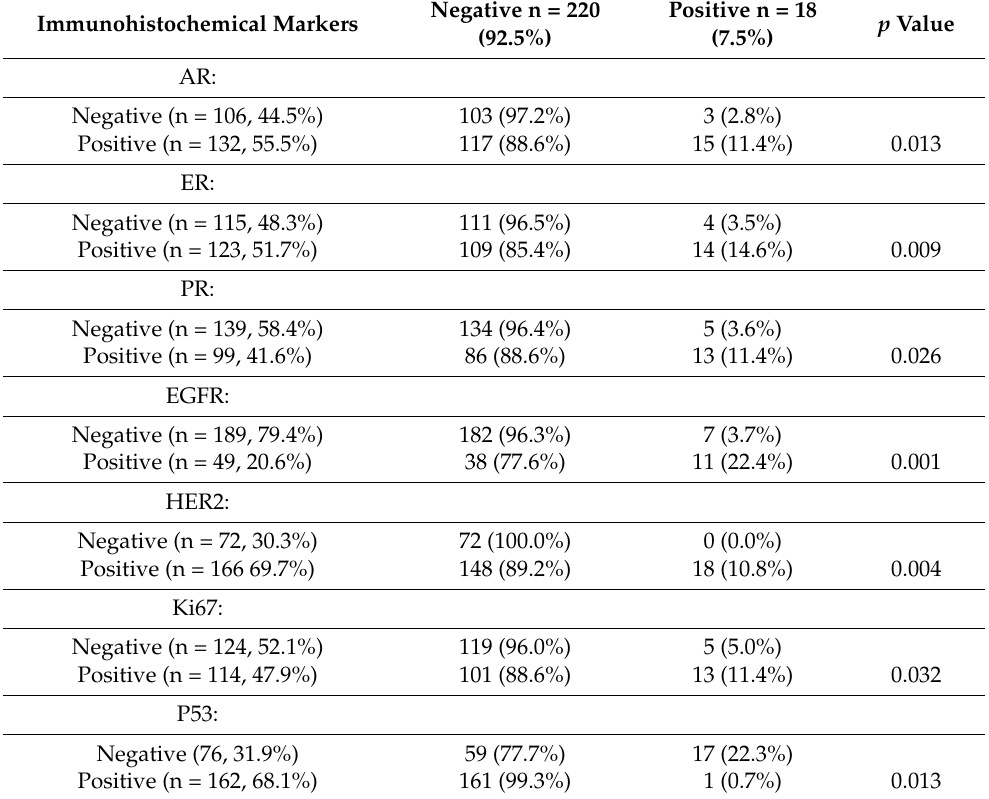
Table 2. Association between GPC3 expression and immunohistochemical markers. androgen receptors (AR), progesterone receptors (PR), oestrogen receptors (ER), epidermal growth factor receptors (EGFR), human epidermal growth factor receptor 2